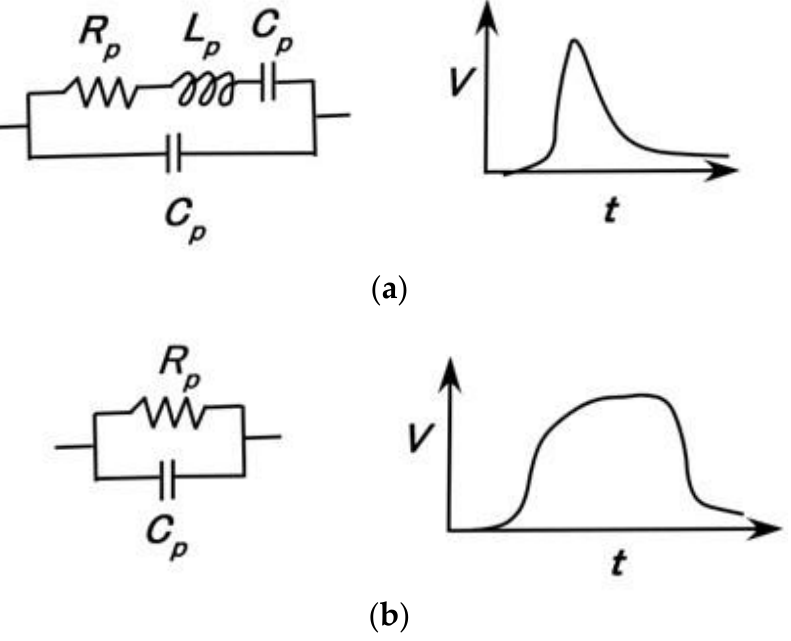
Figure 6. Changes in potential based on FA ( a ) and SA ( b ). The equivalent firing rate, determined from the measured data of the potential of the fabricated finger with the mechanoreceptor upon the application of normal force, is shown in Figure 7. The temperature of the water in the vessel is also shown in the figure. The potential of the mechanoreceptor is the built-in voltage generated from the self-powered HF rubber, as demonstrated in our previous studies [12,13]. The equivalent firing rate is obtained by the differential of the built-in voltage, such that it is estimated as the proportionality of the firing rate, as mentioned